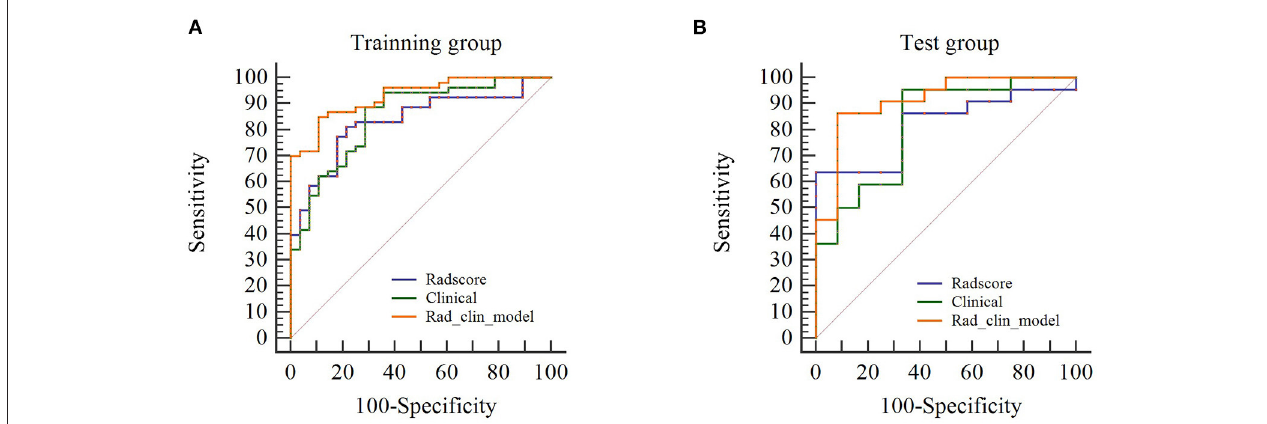
FIGURE 4 | Diagnostic performance of univariate logistic regression model. (A,B) show the receiver operating characteristic curves of the Rad_clin model that show that the area under the curve is the highest among the Radscore and clinical model in the training and testing groups.